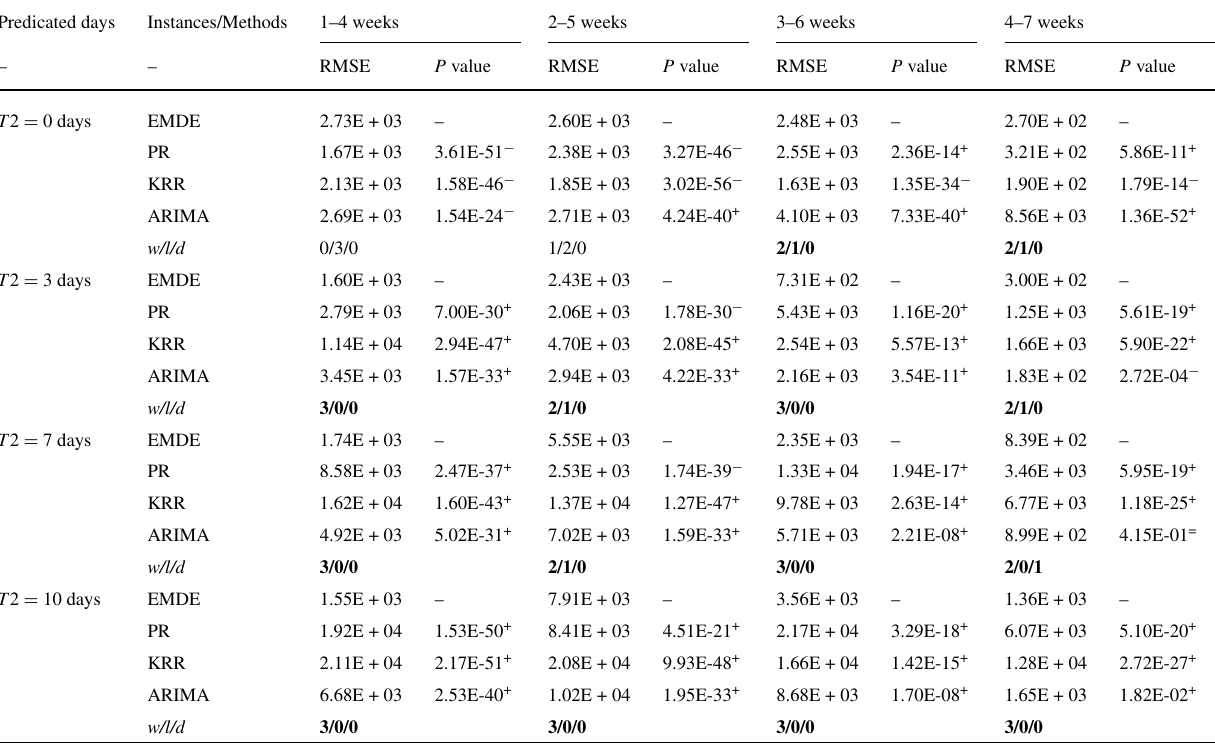
Table 4 Comparison results with data-driven methods for simulation days being 21 days ( T 1 (cid:2) 21) Predicated